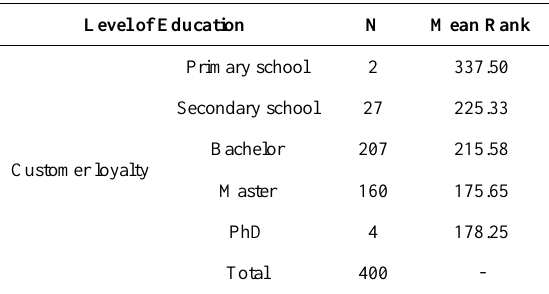
Table 16. Mean rank of level of education